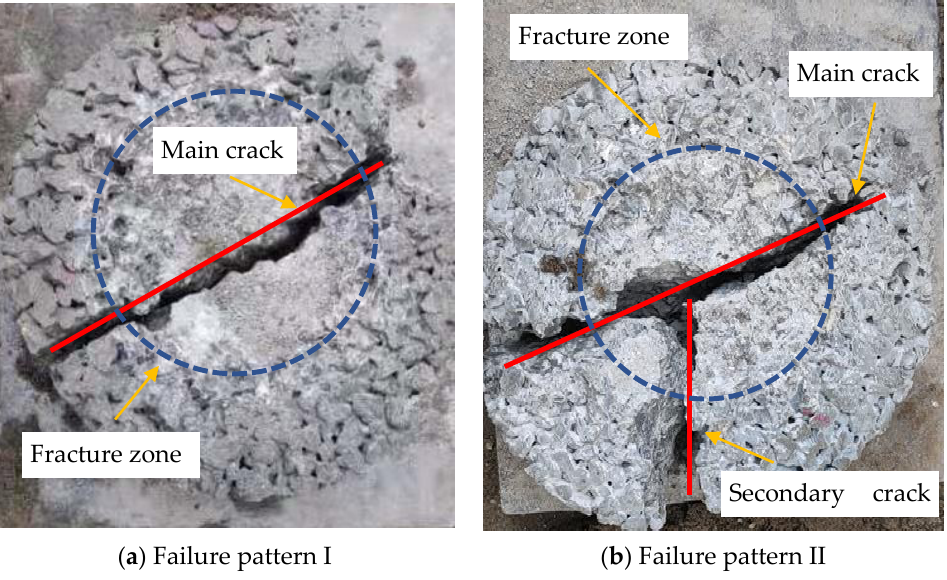
Figure 10. Failure patterns of the CMPC cylindrical specimens.